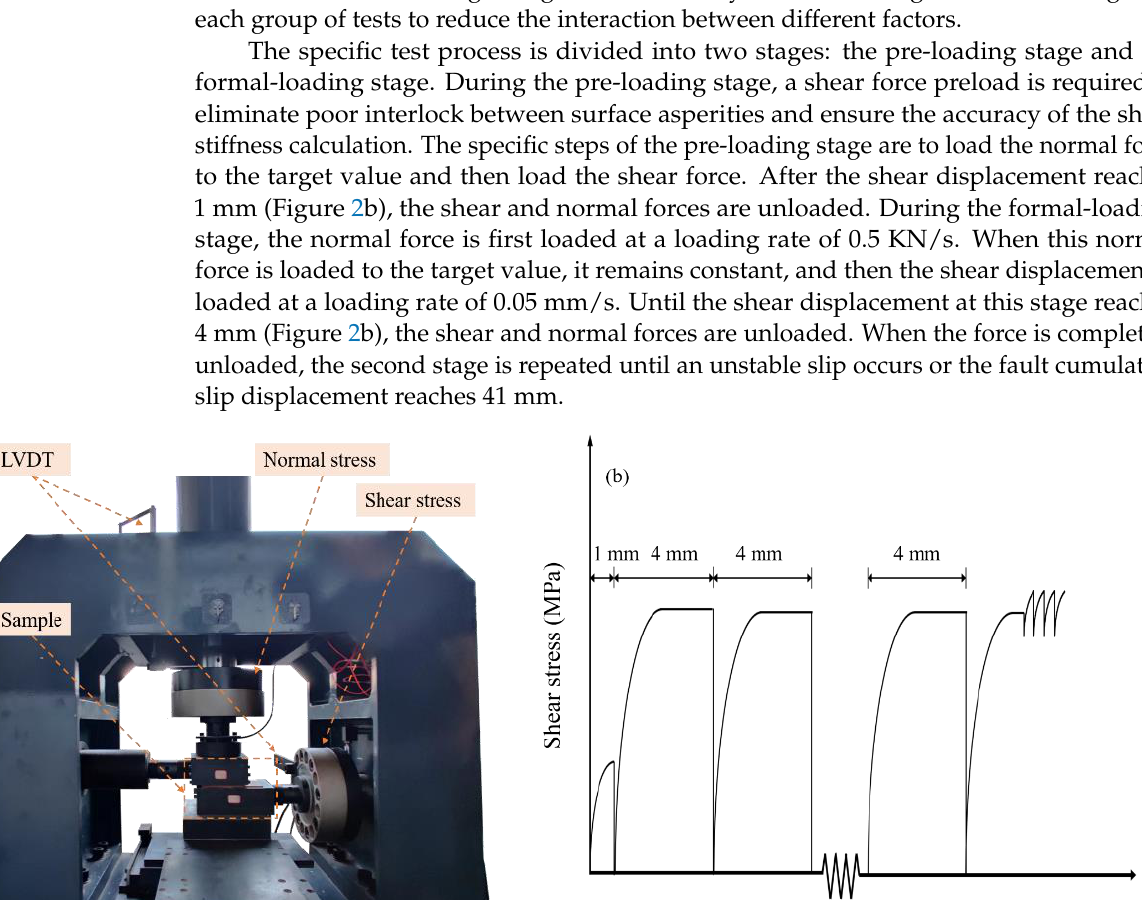
Figure 1. Sample photographs. ( a ) Photograph and dimension of the rock samples. ( b ) Photo of the 3D laser survey of the fault surface, which was roughened with #60 silicon carbide grit sandpapers.